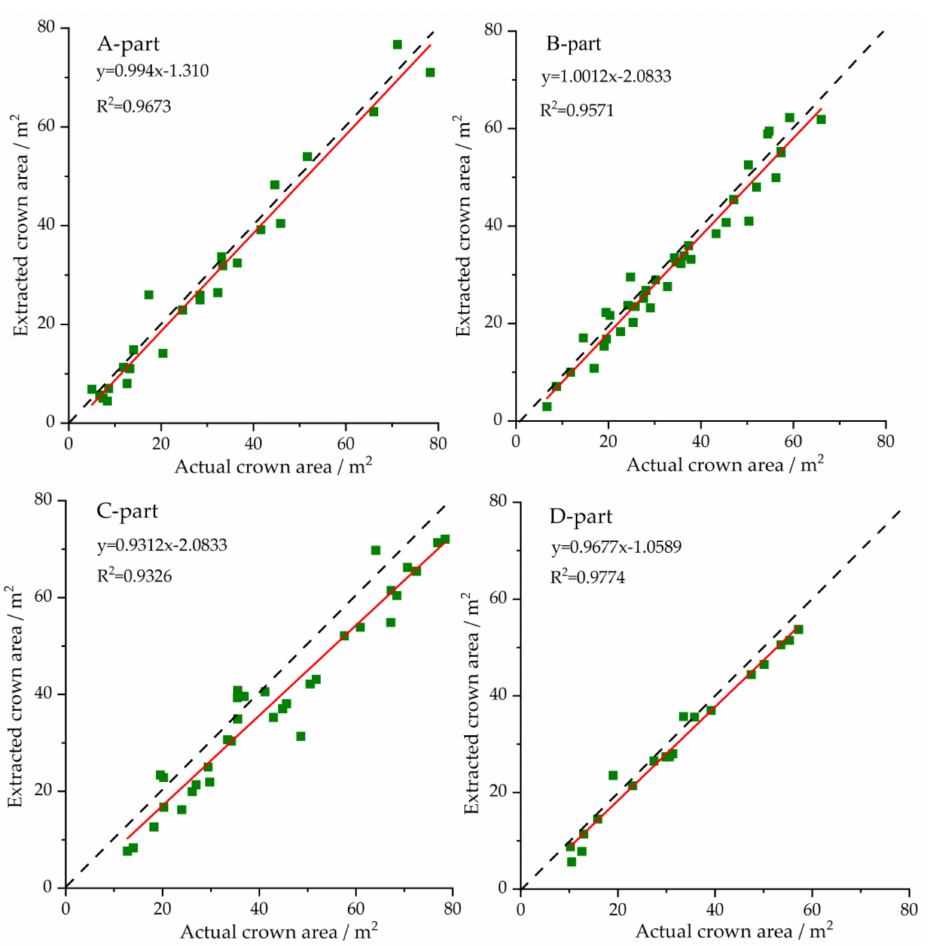
Figure 14. Relationship between extracted area and measured area using the U 2 -Net